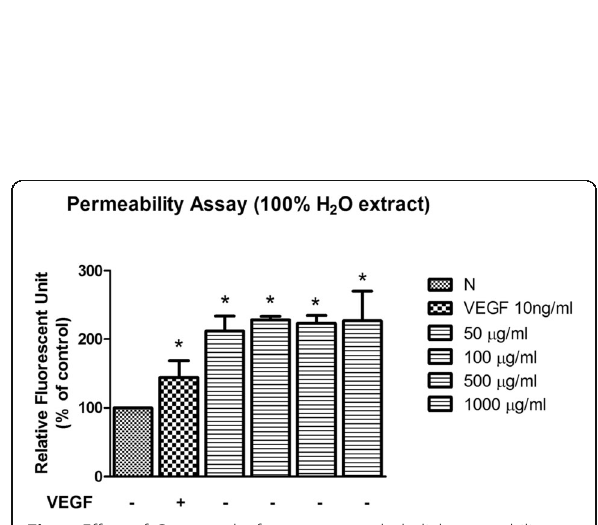
Fig. 7 Effect of C. nutans leaf extract on endothelial